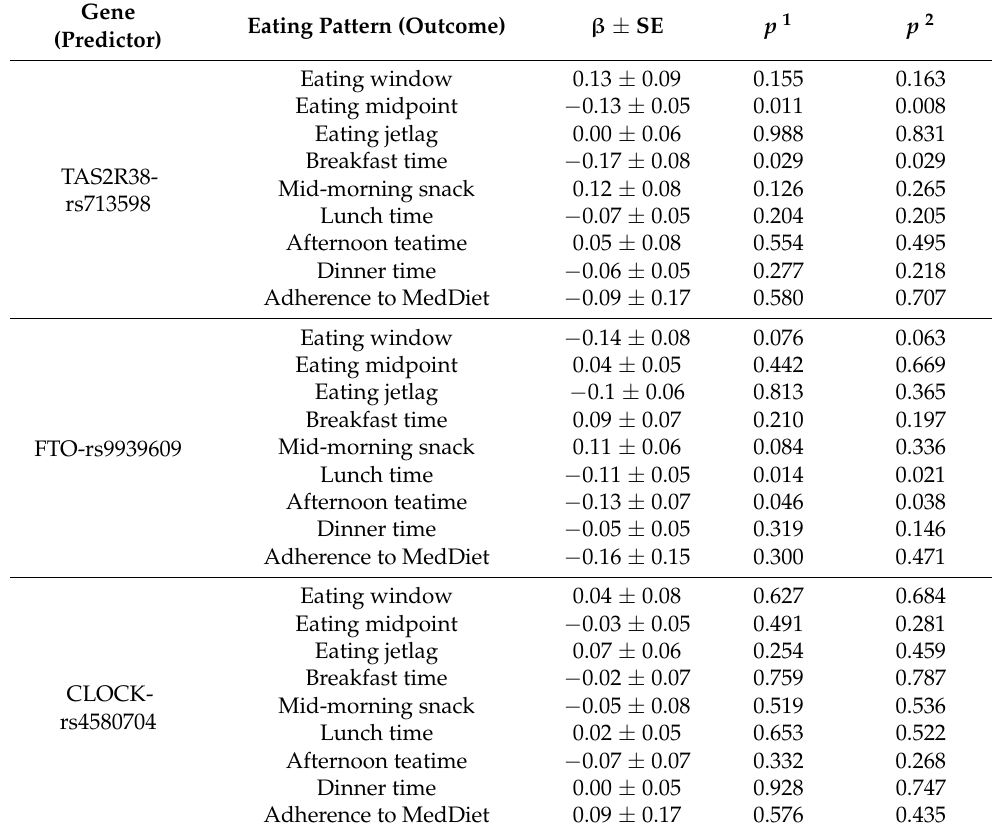
Table 5. Associations between selected polymorphisms and eating